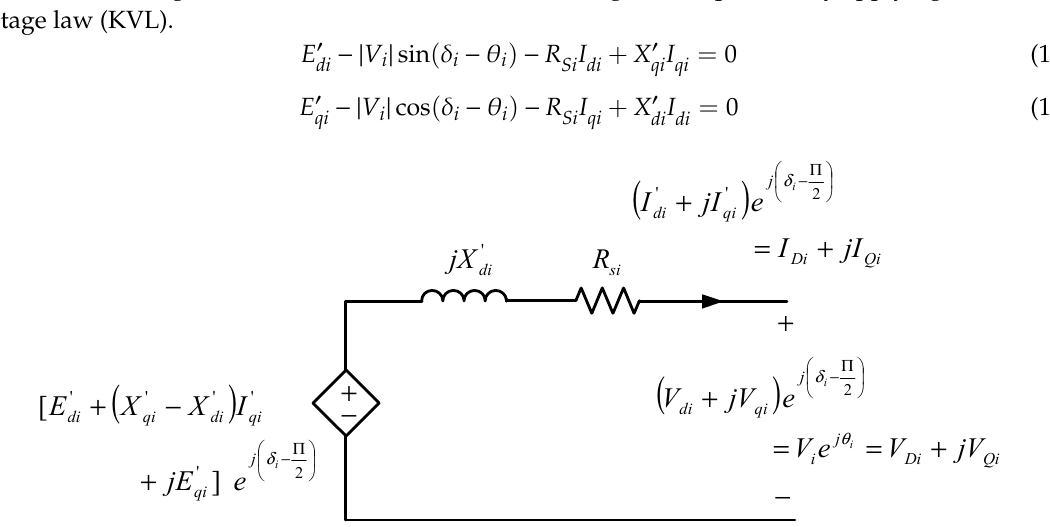
Figure 9. Two-axis dynamic circuit model of an SG.